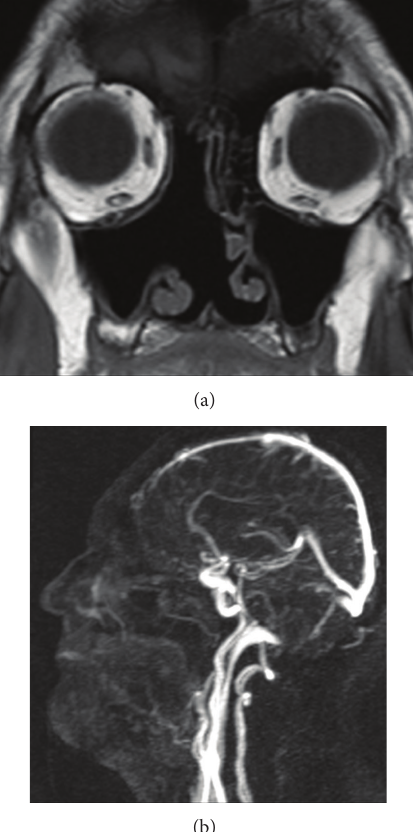
Figure6:MRI(a)andMRIangiography(b)12monthsaftersurgery. The right nasal cavity appears to be free without any signs of tumor recurrence or